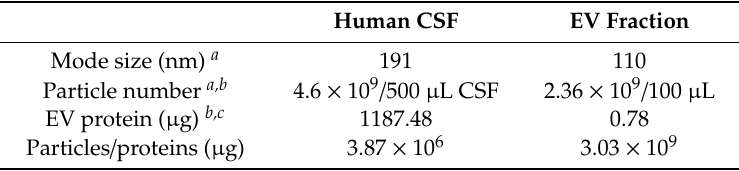
Table 2. Enrichment of EVs separated from CSF by the A ffi nity capture